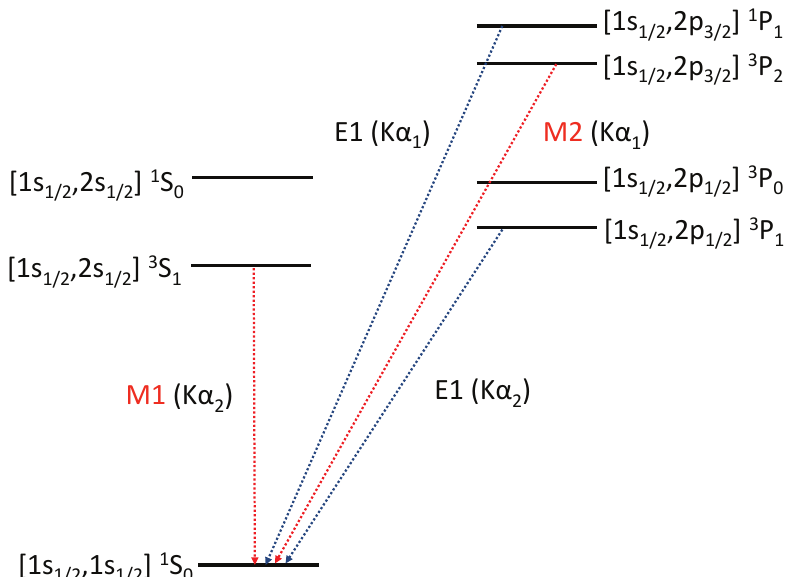
Figure 2. K- and L-shell levels of He-like uranium along with the transitions contributing to the observed K α 1 and K α 2